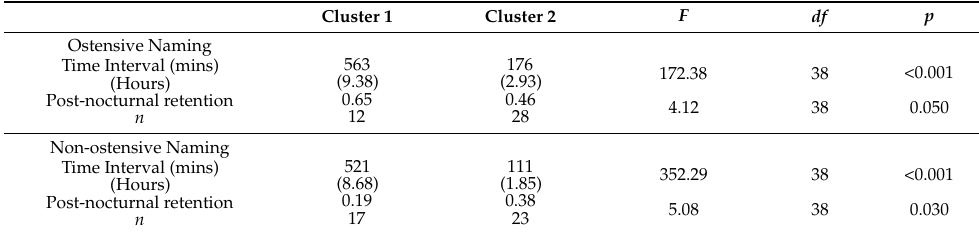
Table 2. K-means Cluster Analyses for the Ostensive and Non-Ostensive Naming